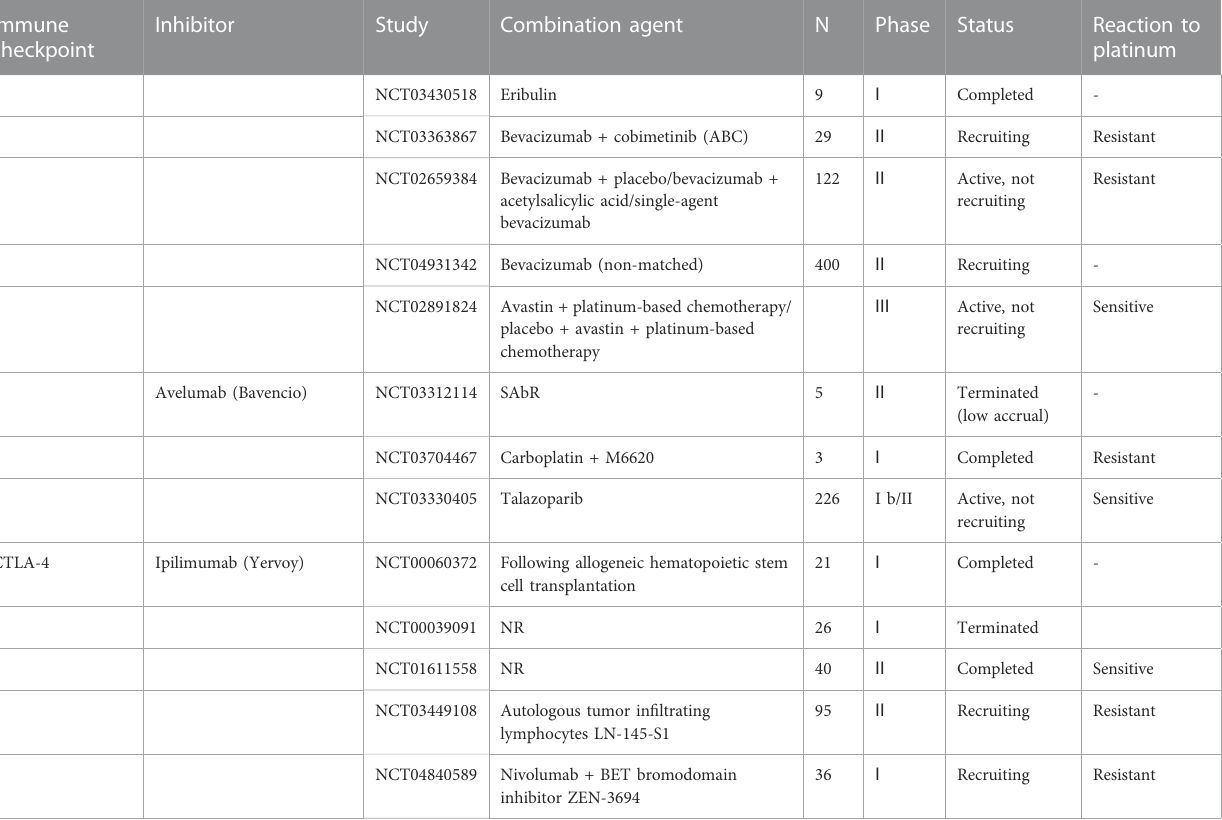
TABLE 3 ( Continued ) Summary of all clinical trials of immune checkpoint inhibitors in the treatment of recurrent ovarian cancer published in Clinical Trials.gov. Immune